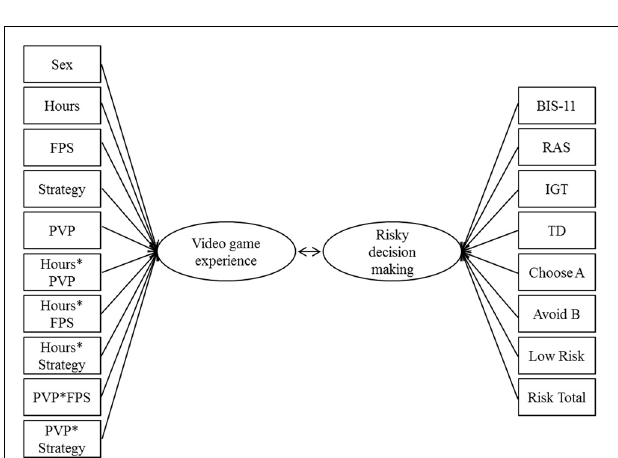
FIGURE 3 | Illustration of the canonical correlation function with ten predictors (boxes on the left side) and eight dependent variables (boxes on the right side). The canonical correlation is the Pearson’s r between the two latent variables (ovals), which are derived from the observed variables.